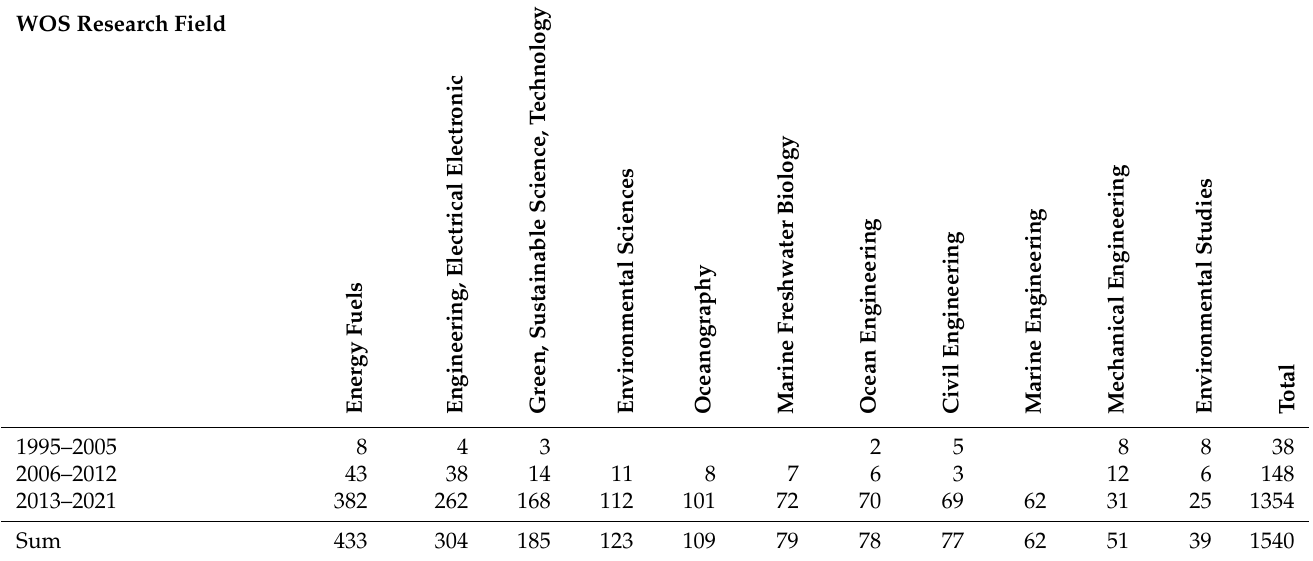
Table 2. The research fields of the WOS papers related to offshore wind farms during the three